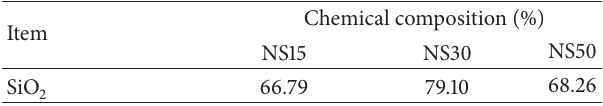
Table 2: Chemical composition of